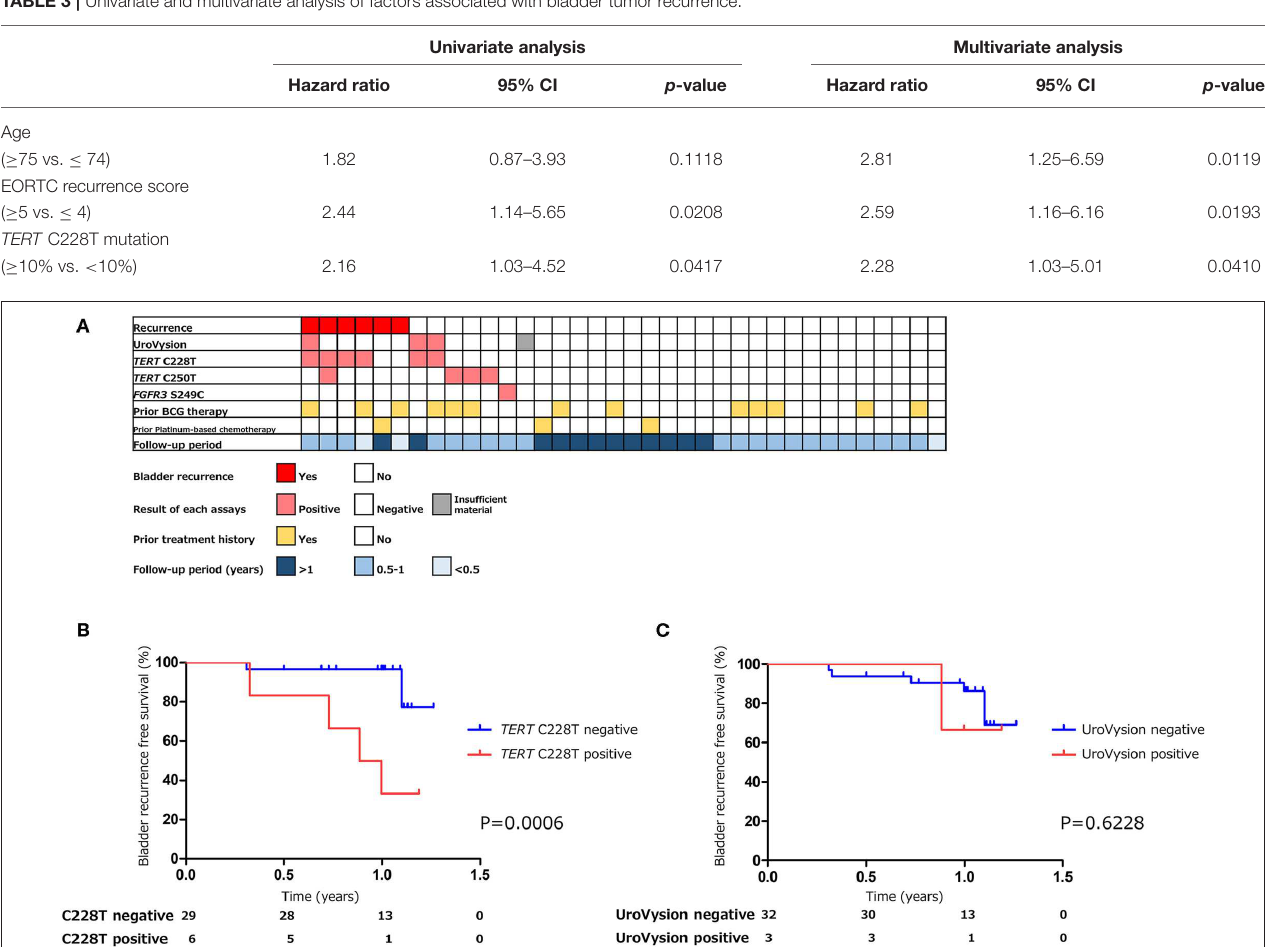
FIGURE 4 | The association of urinary markers and bladder tumor recurrence in surveillance group ( n = 36) (A) . Kaplan–Meier analysis of bladder tumor recurrence free survival of surveillance group stratified by TERT C228T mutation (B) , and UroVysion (C) .